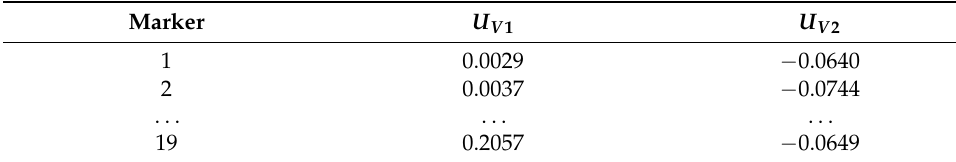
Table 12. Components of the vector π